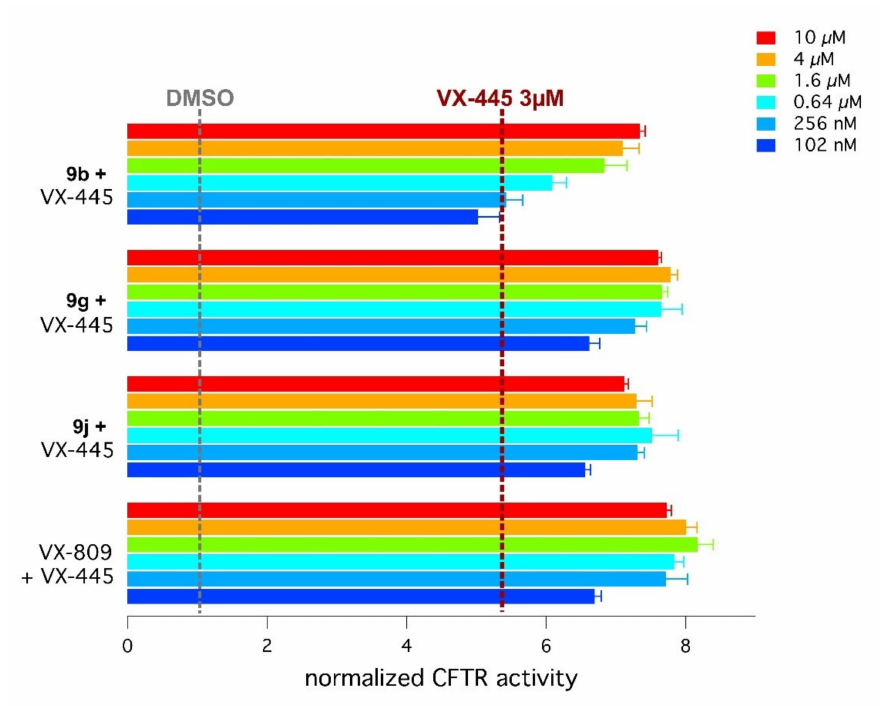
Figure 7. Functional analysis of corrector combinations. F508del-CFTR activity was determined in CFBE41o-cells with stable expression of the HS-YFP. Cells were treated for 24 h with VX-445 (3 µ M) alone or in combination with 9b , or 9g , or 9j , or VX-809 at different concentrations (from 102 nM to 10 µ M). The YFP-based assay was performed after stimulation of CFTR activity with forskolin (20 µ M) plus VX-770 (1 µ